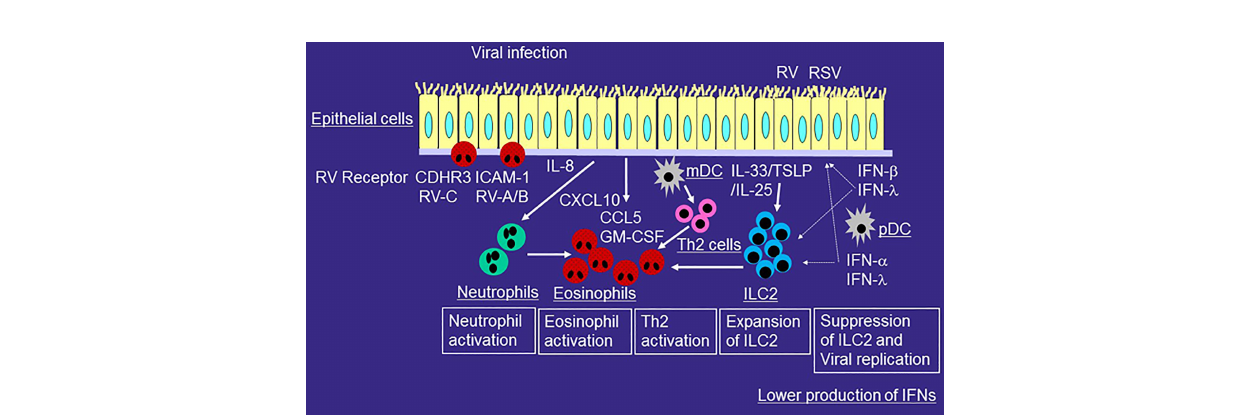
FIGURE 2 | Role of innate immune responses in the development of type 2-mediated airway in fl ammation of asthmatic patients during viral-induced asthma exacerbation. RV or RSV infects airway epithelial cells and is taken up by receptor-mediated endocytosis. After recognition of virus components by PRRs, epithelial cells release proin fl ammatory cytokines and chemokines including IL-6, IL-8, CCL5, GM-CSF, and CXCL10 and antiviral cytokines such as IFN- b and IFN- l . mDCs present viral antigens to naïve T cells for differentiation, whereas pDCs produce IFN- a and IFN- l . The production of IFN from airway epithelial cells or pDCs is lower in patients with asthma or with high IgE as compared with that of healthy individuals. RV or RSV infection induces more IL-33, IL-25, or TSLP expression in airway epithelial cells. Virus-induced IL-33, IL-25, or TSLP increase ILC2s in asthmatic airways and thus induce eosinophilic airway in fl ammation. IL-33 enhances RV- induced airway in fl ammation and suppresses IFN- b or IFN- l expression and anti-viral immunity. Viral infection releases IL-8 from epithelial cells and thus induces neutrophilic airway in fl ammation. Activated neutrophils can accumulate eosinophils in the airway even without chemoattractants for eosinophils. Viral infection releases a variety of mediators including CCL5, GM-CSF, and CXCL10, which can directly activate eosinophils. Receptors of RV such as ICAM-1 and CDHR3 in airway epithelial cells also activate